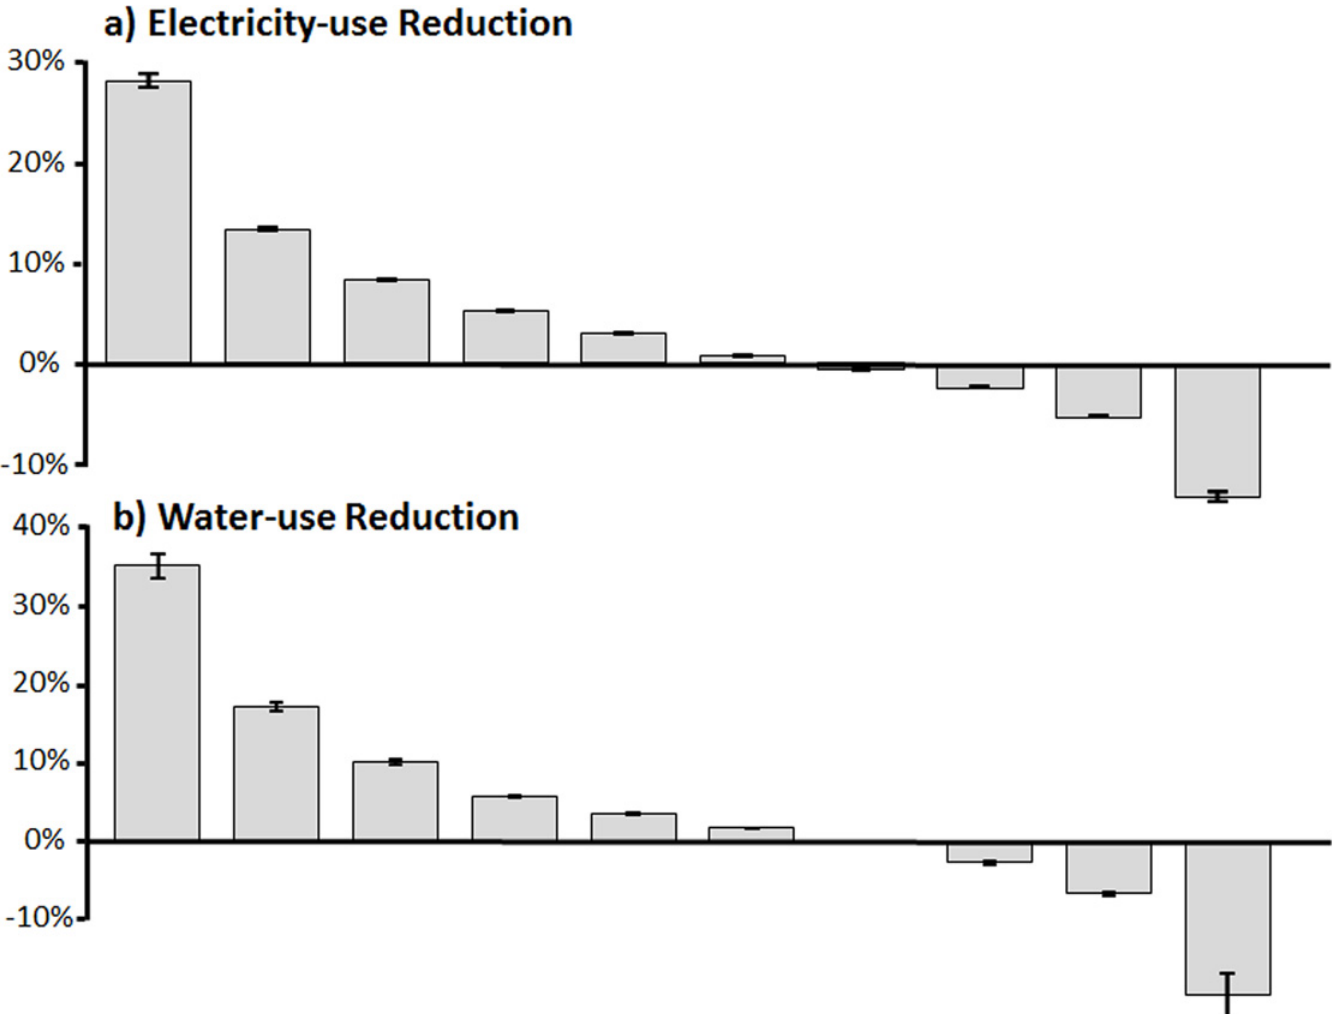
Fig 3. Electricity (a) and water (b) use reductions in the 2010 competition grouped by performance. Each bar is a ten percentile category (47 dorms in each bar for electricity and 10 dorms per bar for water). Error bars are standard error of mean among dorms included in each percentile